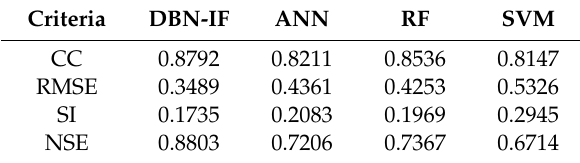
Table 15. The CC, RMSE, SI, NSE of WVHT predictions with lead time = 12 h.